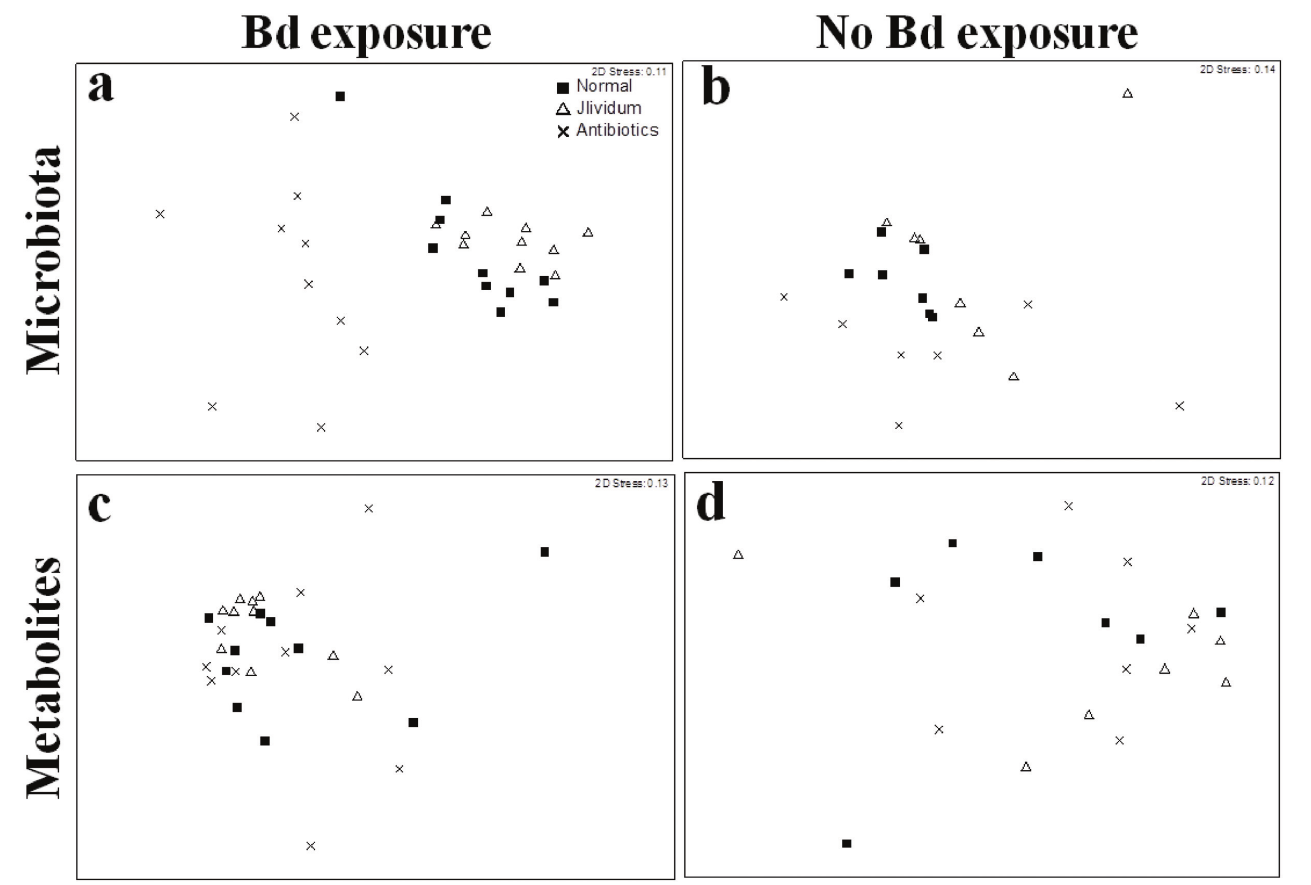
Fig 3. NMDS ordinations based on weighted UniFrac distance matrices (a,b) and Sorensen dissimilarity matrices (c,d) representing differences among microbiota manipulations in microbial community structure and metabolite profiles, respectively, of frogs exposed (a,c) and unexposed (b,d) to Bd one week after initial exposure to Bd. There were differences in microbial community structure and metabolite profiles among microbiota manipulation only with Bd exposure.